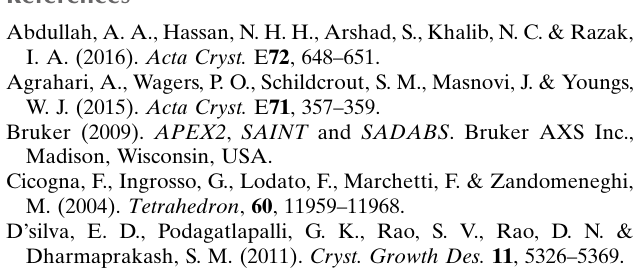
(H) = 1.2 U (C). iso eq